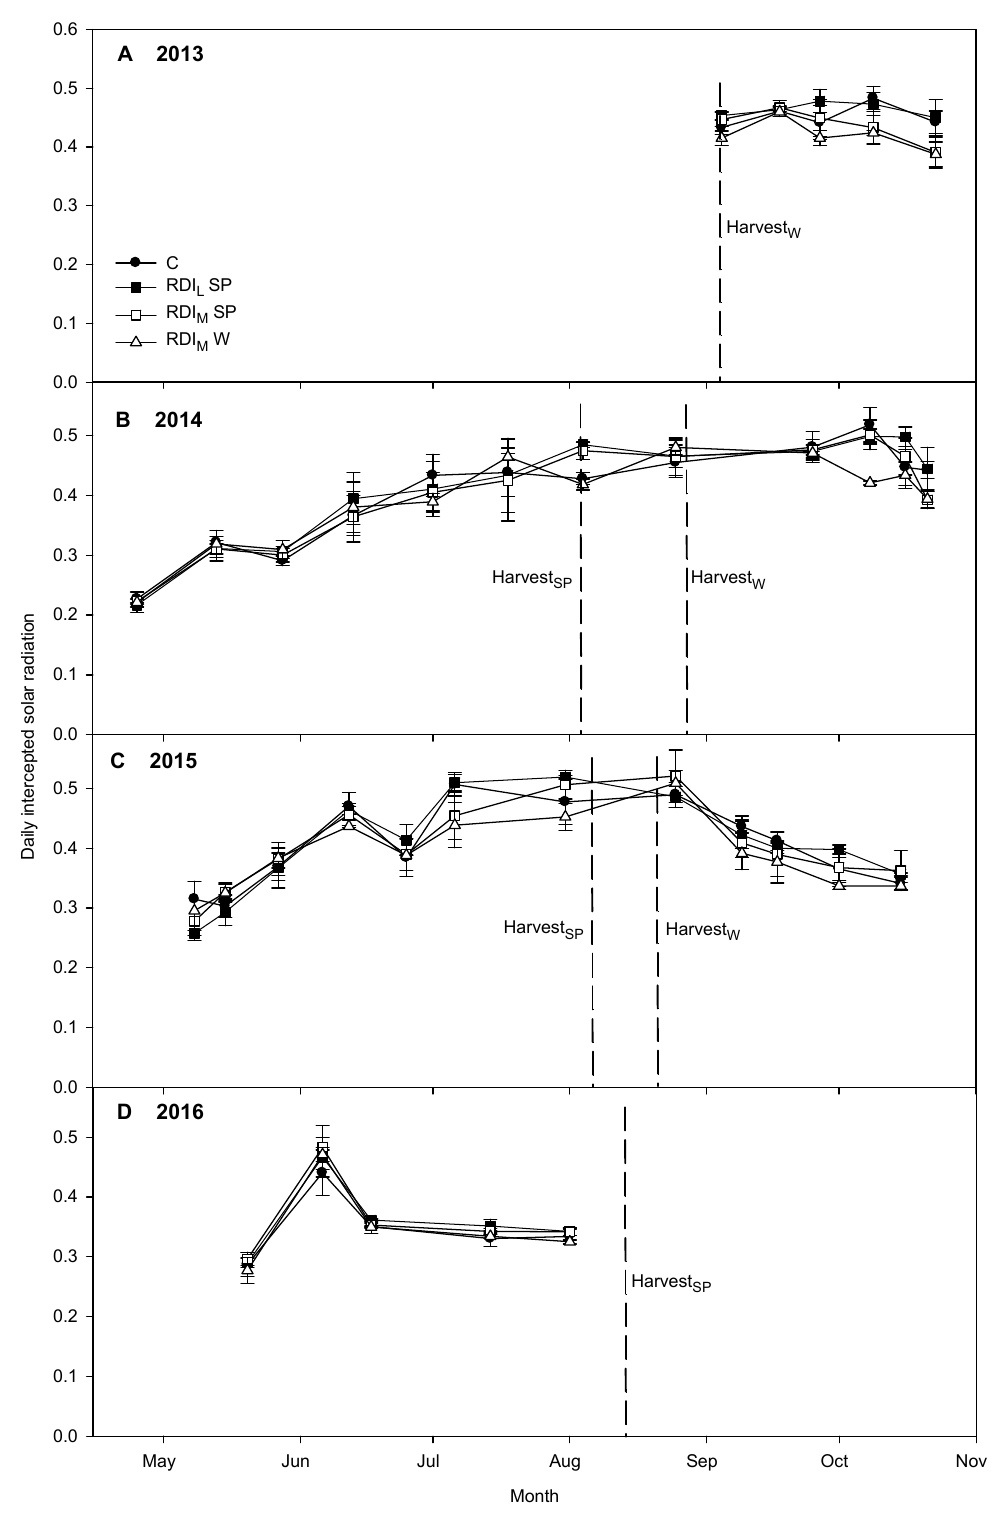
Figure 3. Seasonal variations in daily intercepted solar radiation ( f IRd ) in response to different irrigation treatments in 2013 ( A ), 2014 ( B ), 2015 ( C ), 2016 ( D ). Each value is the mean of four measurements and bars indicate the standard error of the mean. No significant differences were found among the observations. Harvest SP and Harvest W indicate the harvest time according to sparkling base wine and wine criteria, respectively.